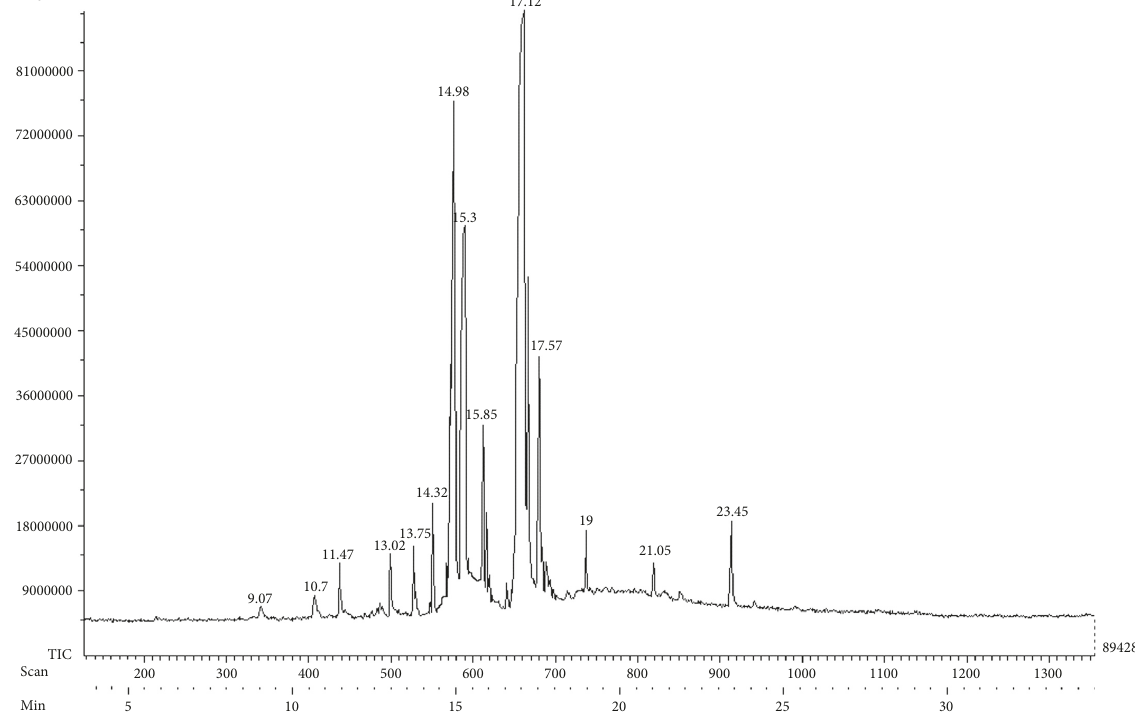
Figure 1: Gas chromatogram of polyherbal ethanolic extract indicating bioactive compounds. Table 1: Phytocomponents of polyherbal ethanolic extracts identified by GC-MS analysis.